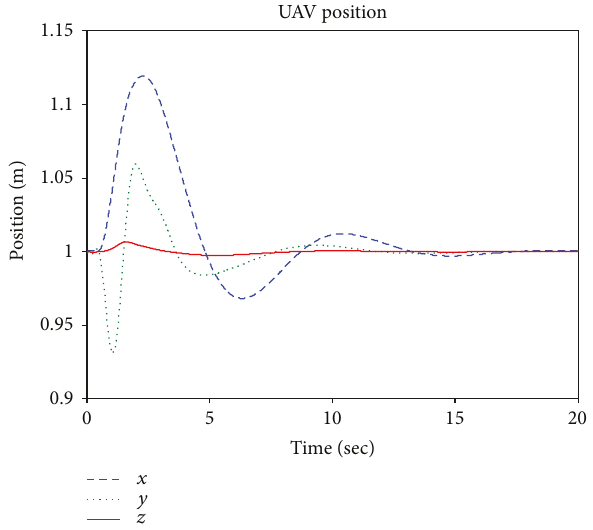
Figure 10: Position of the UAV in the inertial frame.